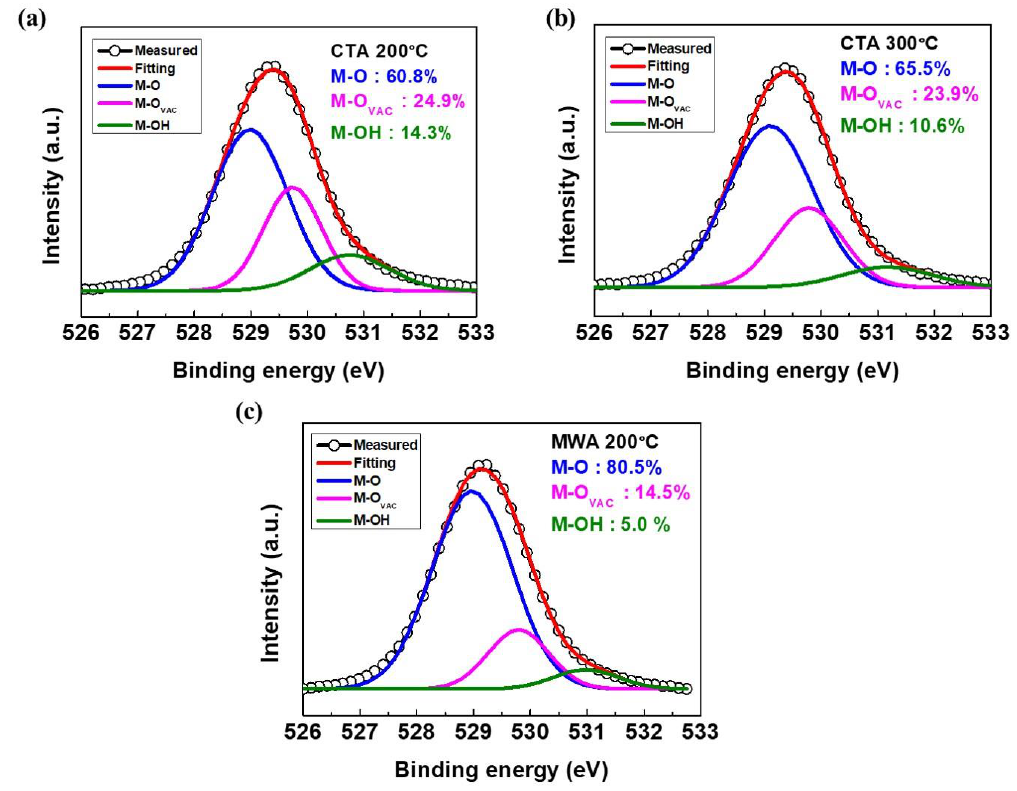
Figure 3. XPS O1s peak of the a-IGZO TFTs annealed by ( a ) CTA at 200 ◦ C, ( b ) CTA at 300 ◦ C, and ( c ) MWA at 200 ◦ C. The three peaks at 529, 530, and 531 eV correspond to the latticed oxygen, oxygen vacancies, and loosely bound oxygen impurities (such as chemisorbed oxygen),